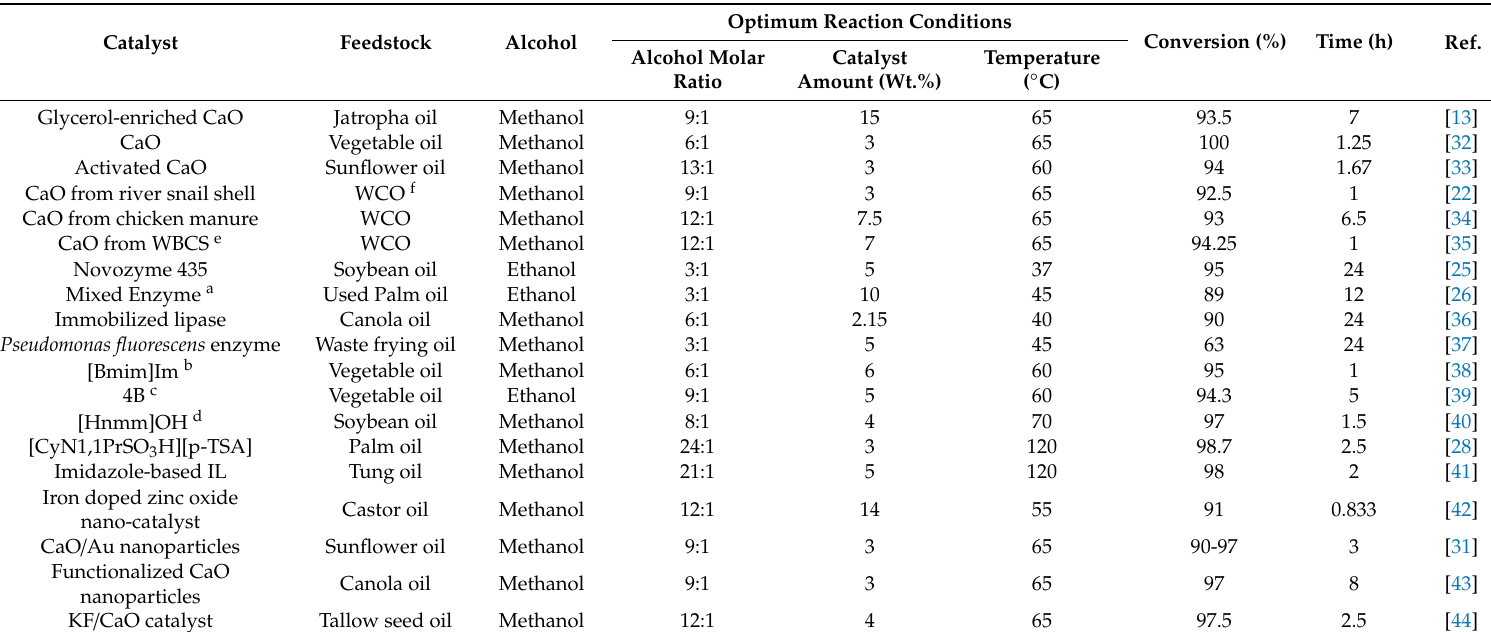
Table 1. Optimum reaction conditions for biodiesel production from di ff erent feedstock using four di ff erent catalyst categories: bulk CaO, enzyme, ionic liquid, and nanoparticle